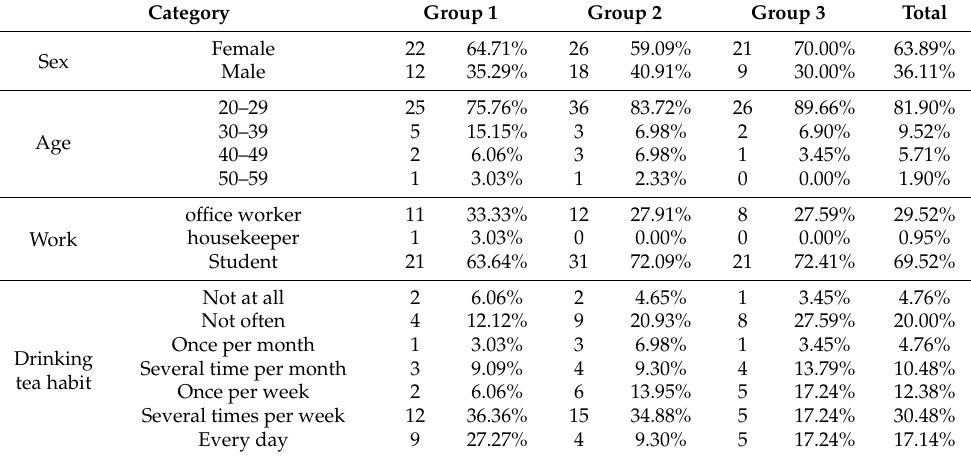
Table 2. The characteristics of clusters of consumers in this study ( n =